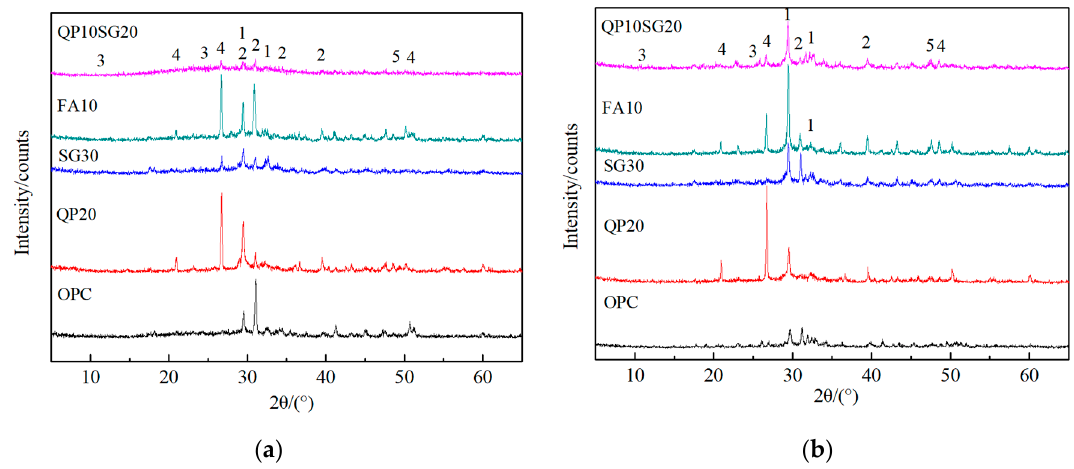
Figure 4. XRD diagram of the hydration product from the same age of the specimen after standard curing and 300 sulfate dry–wet cycles. ( a ) standard curing ( b ) 300 sulfate dry–wet cycles. (1: Tobermorite; 2: Portlandite; 3: Gypsum; 4: Quartz; 5: Tricalcium aluminate).